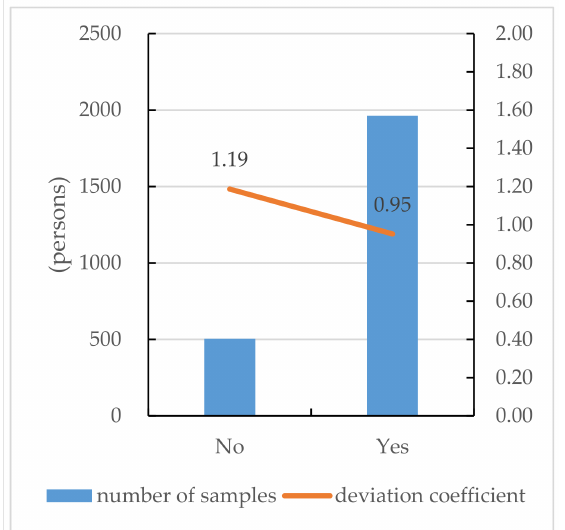
Figure 19. Deviation coefficient of agricultural machinery utilization rate grouped by agricultural machinery purchase subsidy policy.